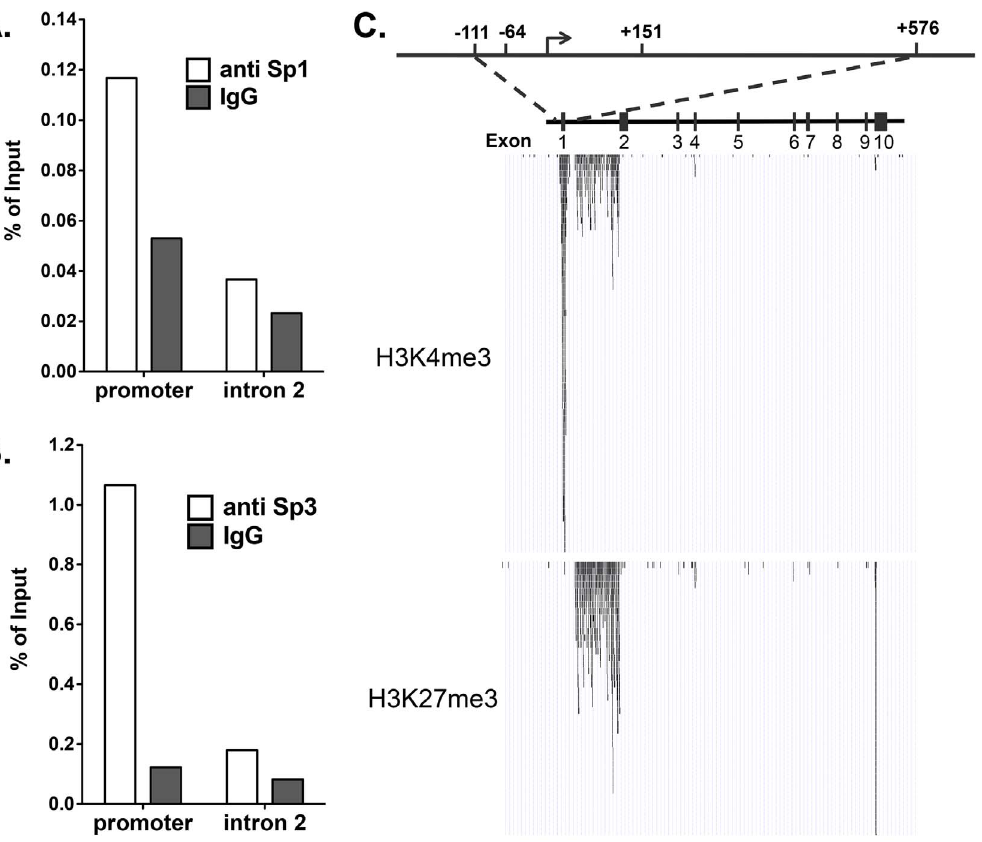
Figure 6. Sp1 and Sp3 binding to the Mina promoter in resting CD4 + T cells. (A) The Mina promoter was marked as an epigenetically active region in resting CD4 + T cells. Chromatin fragments from CD4 + CD62L Hi CD44 2 CD25 2 T cells of C57BL/6 mice were immunoprecipitated with antibody to either H3K27me3 or H3K4me3, and then subjected to high-throughput sequencing (ChIPseq). The ChIPseq signals from both anti- H3K27me3 (upper panel) and anti-H3K4me3 (lower panel) are shown with correlations to the Mina locus. The depth of the peaks in the histograms corresponds to the number of reads mapped to the location. A schematic of the Mina locus is shown above the histograms. Each box represents an exon. The region that enriched for H3K4me3 but was devoid of H3K27me3 modifications is enlarged and shown above the Mina locus schematic. (B– C) ChIP assay confirmed the binding of Sp1 and Sp3 to the Mina promoter in EL4 cells. Chromatin fragments from CD4 + CD62L Hi CD44 2 CD25 2 T cells of BALB/c mice were immunoprecipitated with antibodies against Sp1 (B, open bars), Sp3 (C, open bars), or their corresponding IgG controls (B–C, filled bars). Promoter: Mina promoter region; Intron 2: an Intron 2 region located , 6 kb downstream of the Mina promoter.